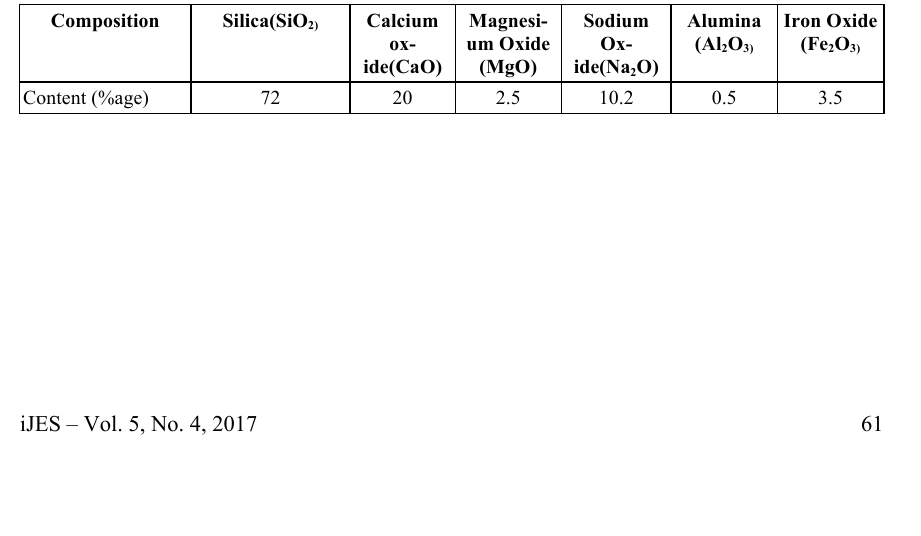
Table 1. chemical composition of glass